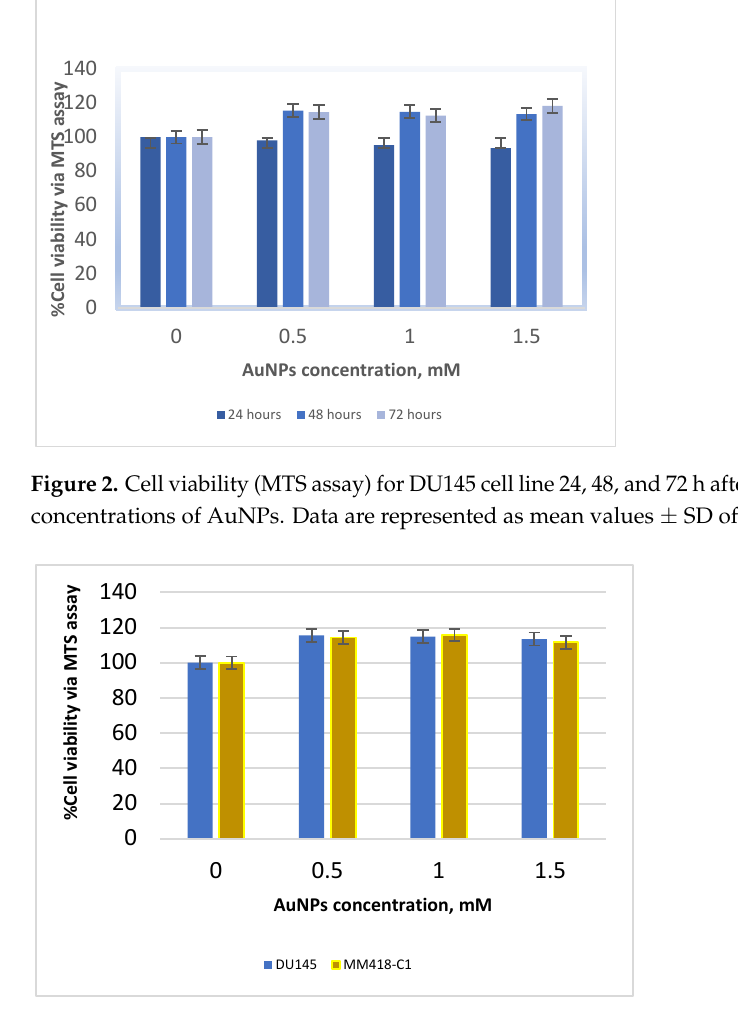
Figure 3. Comparison of cell viability (MTS assay) for DU145 and MM418-C1 cell lines 48 h after being treated with various concentrations of AuNPs. Data are represented as mean values ± SD of three replicate samples.